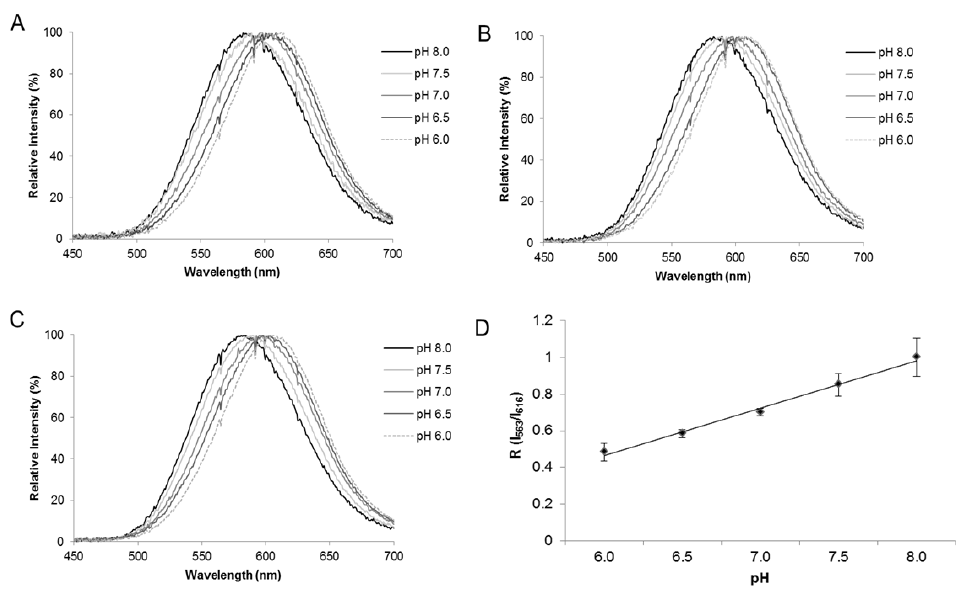
Figure 7. Bioluminescence spectra in COS-1 cells transfected with Macrolampis firefly luciferase carrying vector, pCMV-Mac, and ratiometric curves. Effect of pH in cells transfected with: ( A ) pCMV-Mac;cytoplasm; ( B ) pCMV-Mac-Nucleus; ( C ) pCMV-Mac with calibration buffer containing nigericin at different pHs (pH 6.0, 6.5, 7.0, 7.5 and 8.0); ( D ) ratiometric analysis between R (Igreen/Ired) and pH. Reprinted with permission from ref. [34]. Copyright 2019 Royal Society of Chemistry.